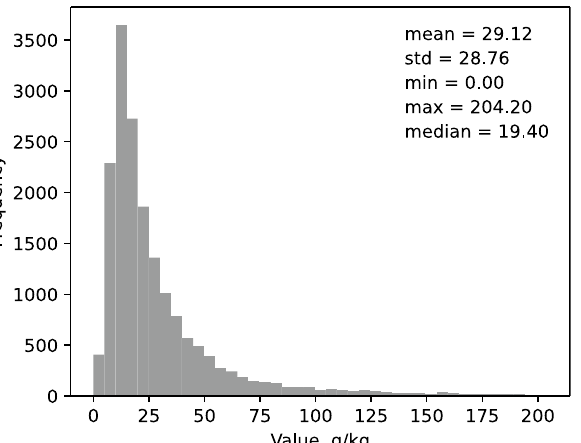
Figure 5. Histogram of the soil organic carbon (SOC) content in the LUCAS dataset ( n = 17,607 ), showing moments of its distribution. The dataset includes both mineral and organic